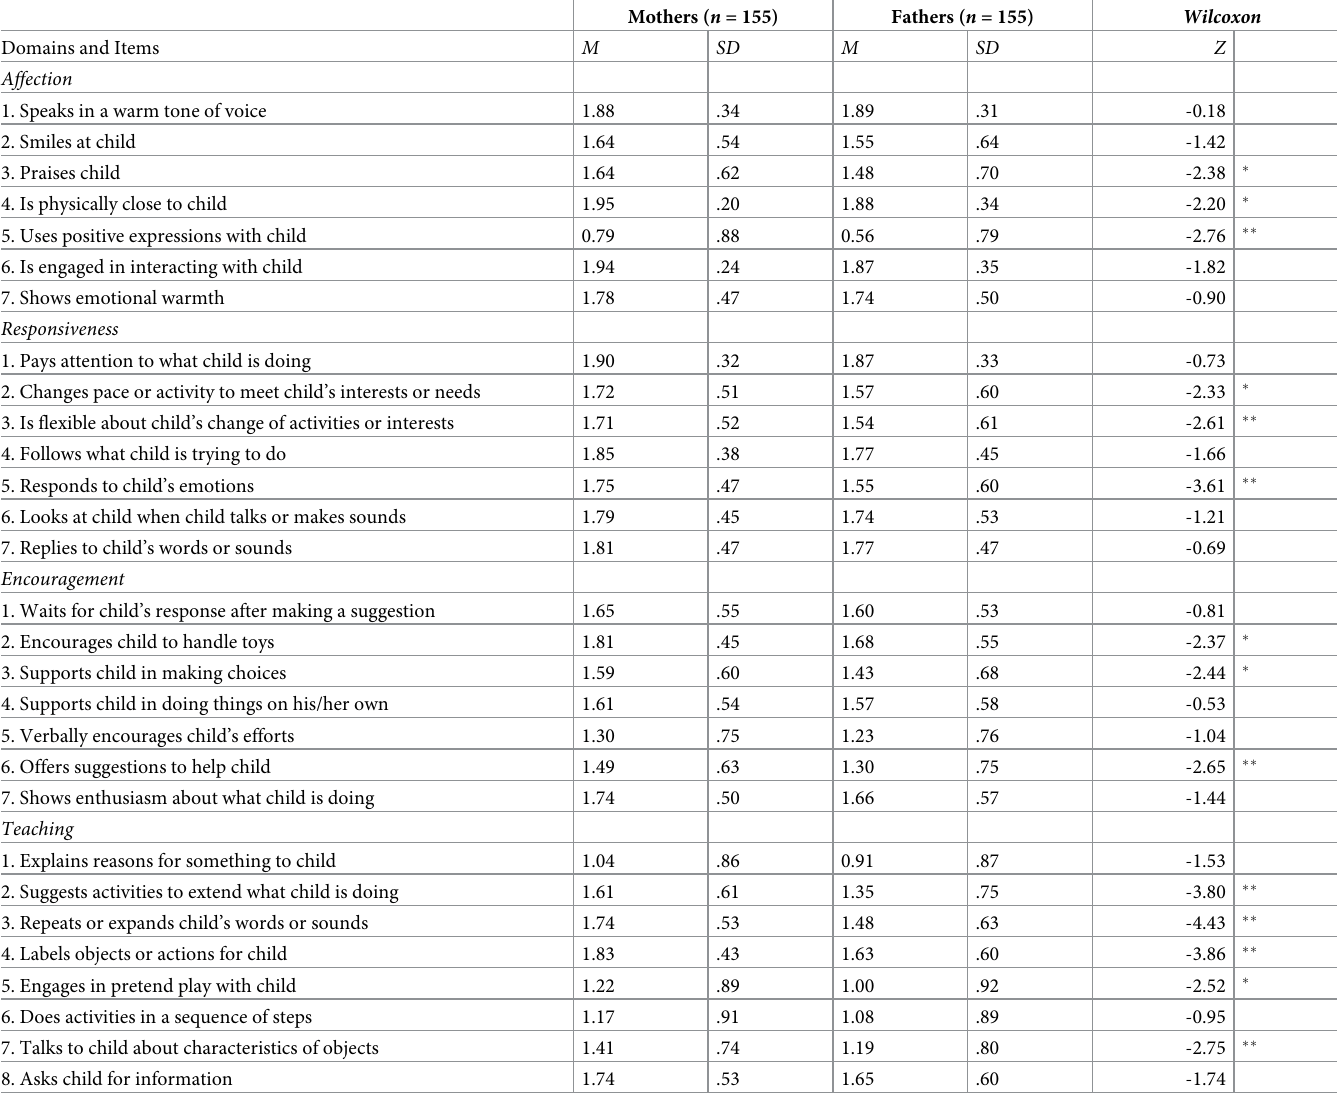
Table 1. Descriptives of PICCOLO item scores for mothers and